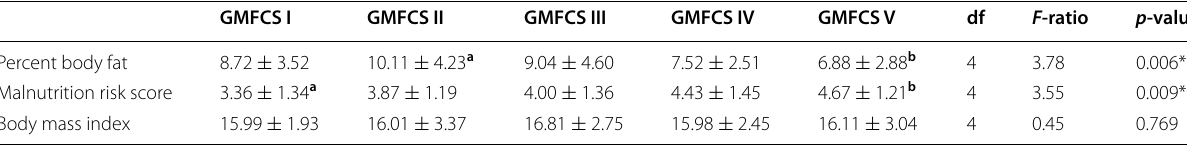
Key *significant. Post hoc analysis with Bonferroni correction showed that items with superscripts are significantly different. GMFCS gross motor function classification system